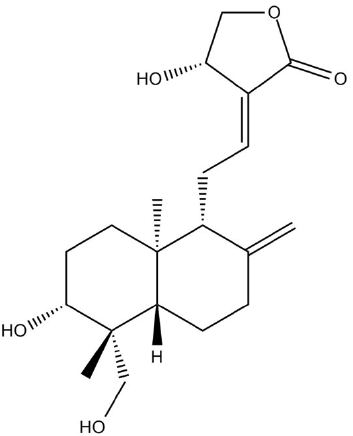
Figure 1. Stucture of